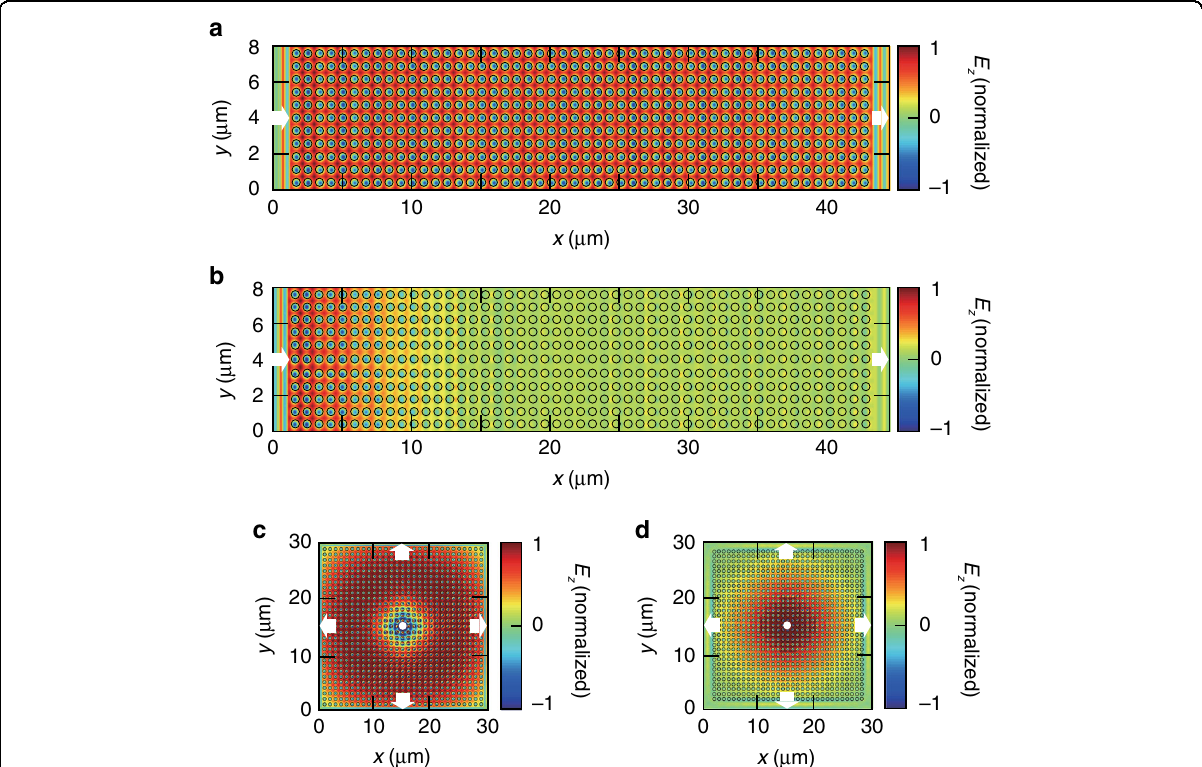
Fig. 6 Electric fi eld distributions over large-area zero-index PhC slabs with (a, c) and without (b, d) BICs. a , b The PhC slab is excited by a plane wave incident from the left. c , d The PhC slab is excited by an electric dipole at the centre of the material. The structural parameters of the BIC zero-index PhC slabs in ( a , c ) are r = 180 nm, a = 733 nm, and h = 1085 nm. The structural parameters of the zero-index PhC slabs without BICs in ( b ) are r = 180 nm, a = 733 nm, and h = 1200 nm and ( d ) are r = 180 nm, a = 733 nm, and h = 1247